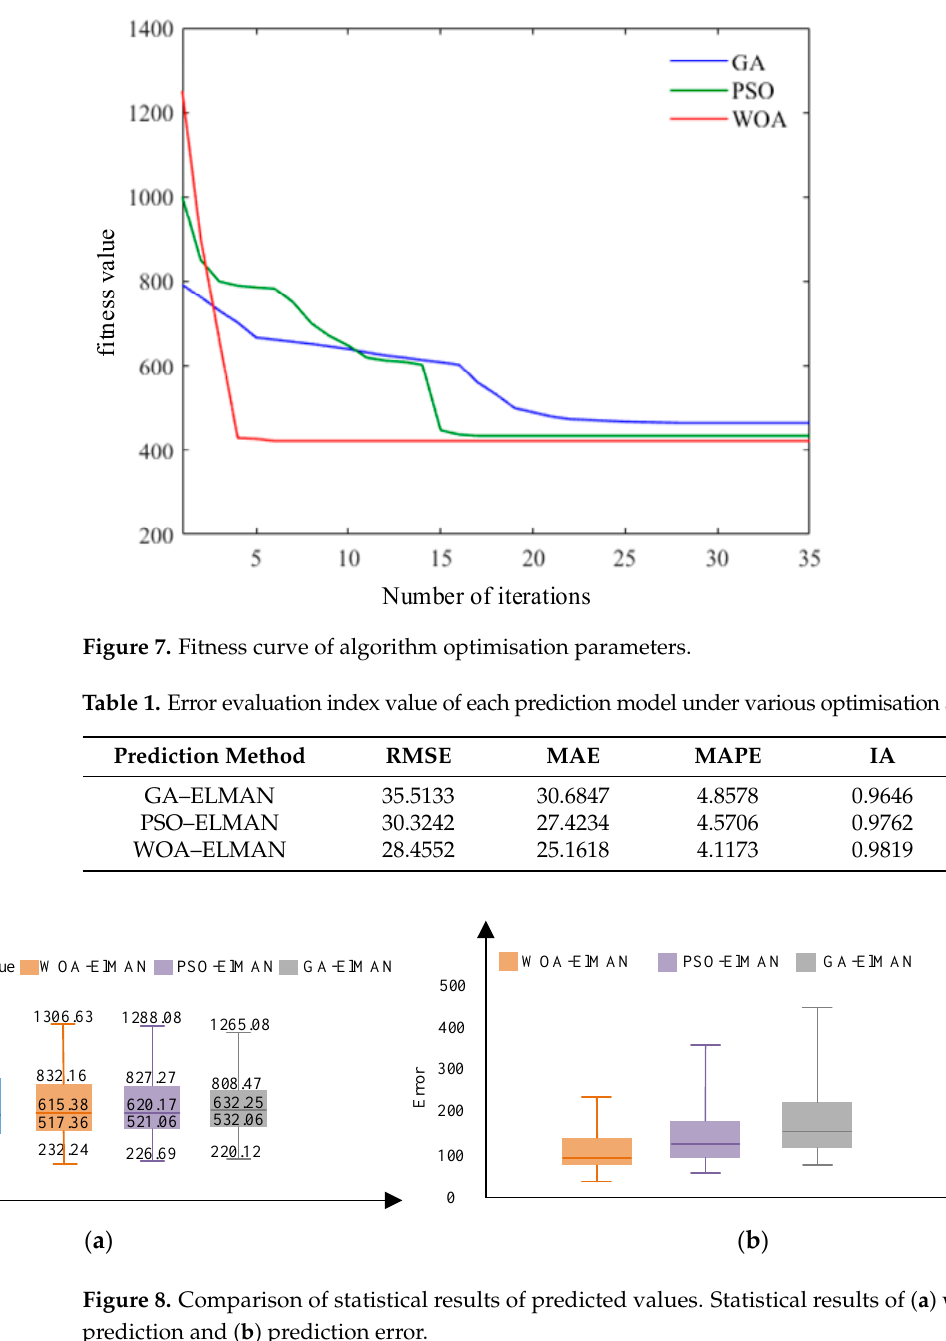
Figure 7. Fitness curve of algorithm optimisation parameters.